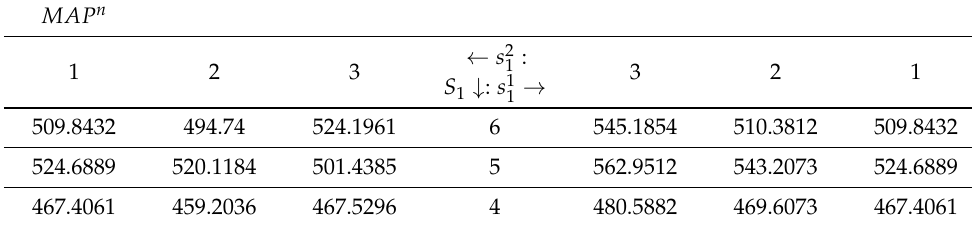
= 1) and ( s 2 , S 1 ) (fix s 2 1 1